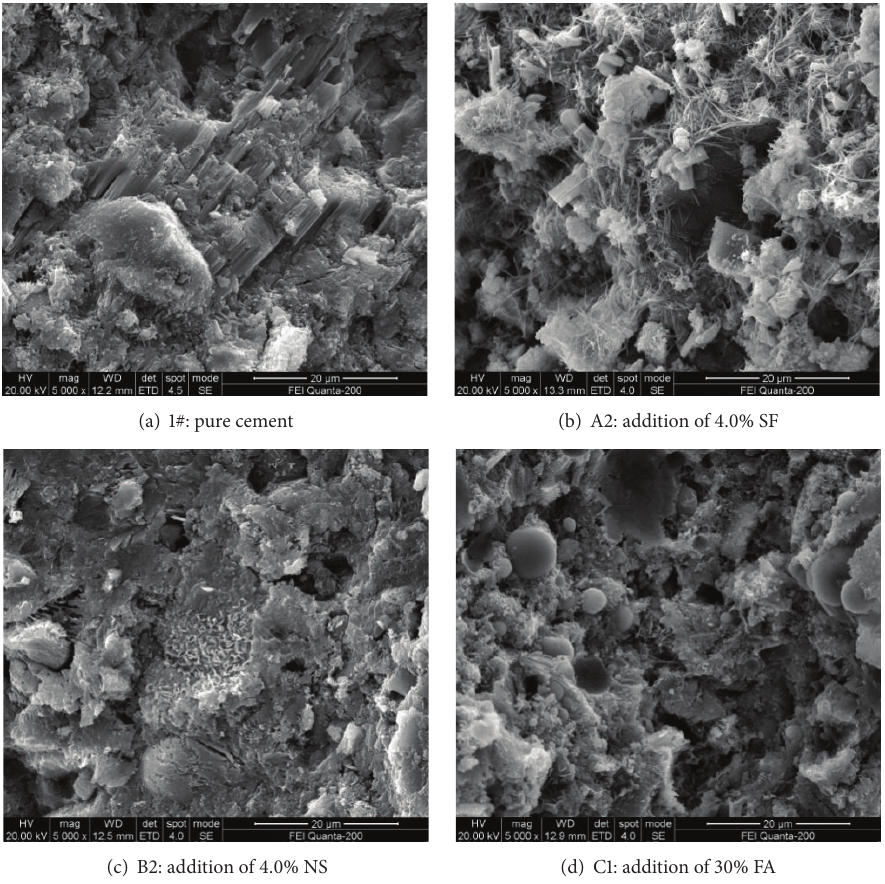
Figure 8: SEM photographs of 1#, A2, B2, and C1 samples at the age of